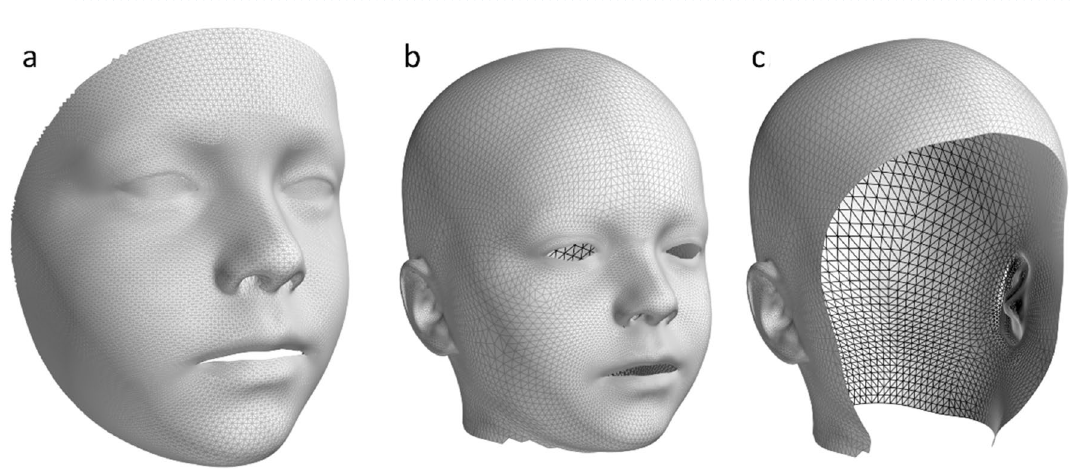
Figure 4. Mesh templates. ( a ) Face only template, ( b ) Head and Face template, ( c ) Head only